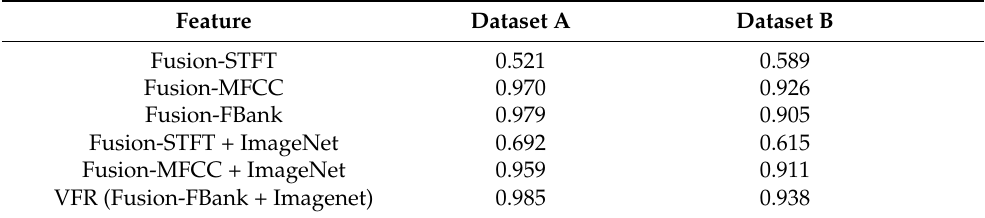
Table 4. The recognition accuracy of three feature extraction methods before and after using